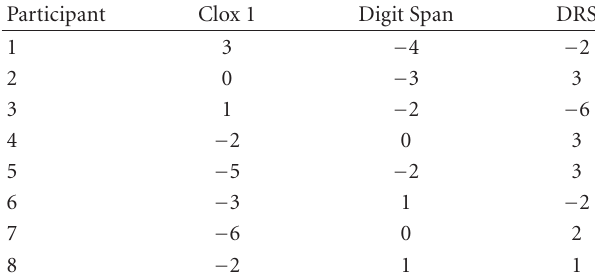
Table 1: Change of individual performance on Clox 1, WAIS Digit Span, and the DRS. The change in value for each individual’s performance on each test over 6 months. Values represent the per- formance at 6 months minus the respective performance at